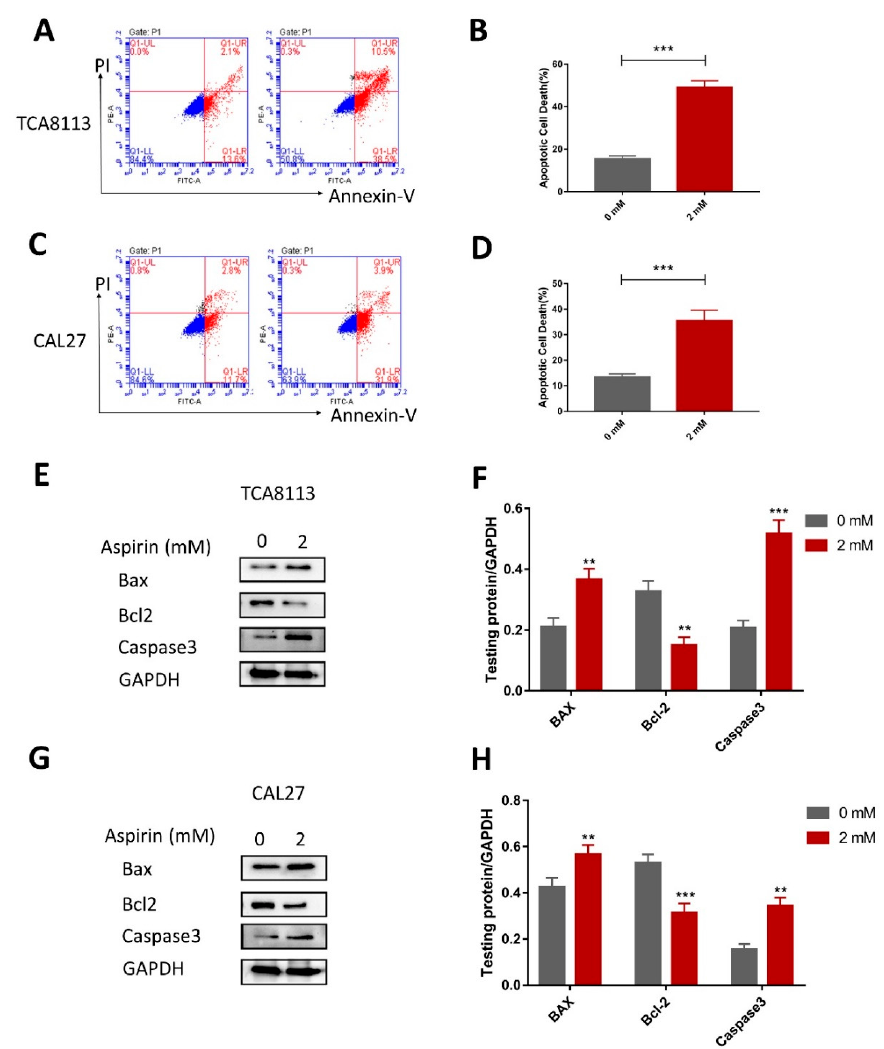
Figure 4. Aspirin promoted apoptosis in the TCA8113 and CAL27 cells. ( A , B ) The apoptosis cell rates were increased with ASA treatment in the TCA8113 cells. The apoptotic cells were detected by flow cytometry after staining with Annexin V and PI after cells were treated with 2 mM ASA for 24 h. ( C , D ) Similar results were observed in CAL27. ( E , F ) The ASA treatment increased the expression of Bax and caspase3, and inhibited the expression of Bcl-2. Apoptosis related protein levels were detected by Western blotting using indicated antibodies, and GAPDH was used as a loading control. ( G , H ) Similar results were observed in CAL27. ** p < 0.01 and *** p < 0.005. The data were presented as the mean ± SD ( n = 3).